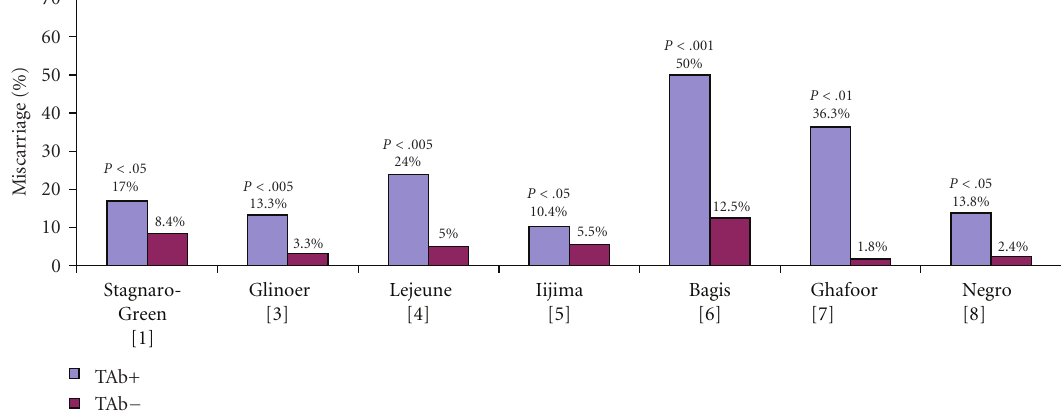
Figure 1: Percentage of spontaneous miscarriage in unselected pregnancies in women who were thyroid antibody positive (TAb+) and thyroid antibody negative (TAB − ).